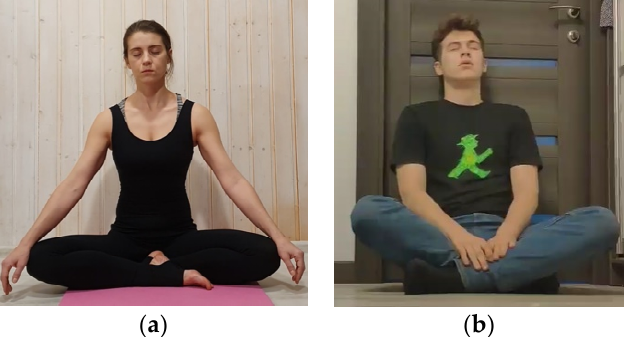
Figure 9. Dataset example: ( а ) professional in lotus pose, ( b ) beginner in lotus pose.